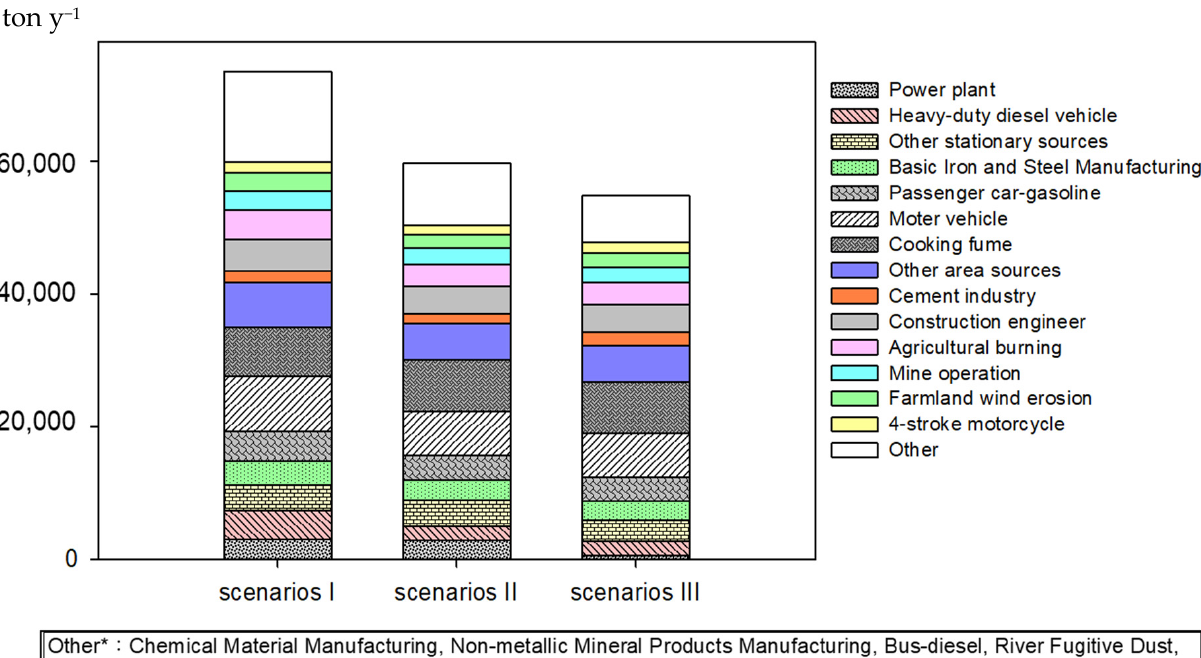
Figure 4. NOx emission sources for different scenarios (ton y − 1 ).